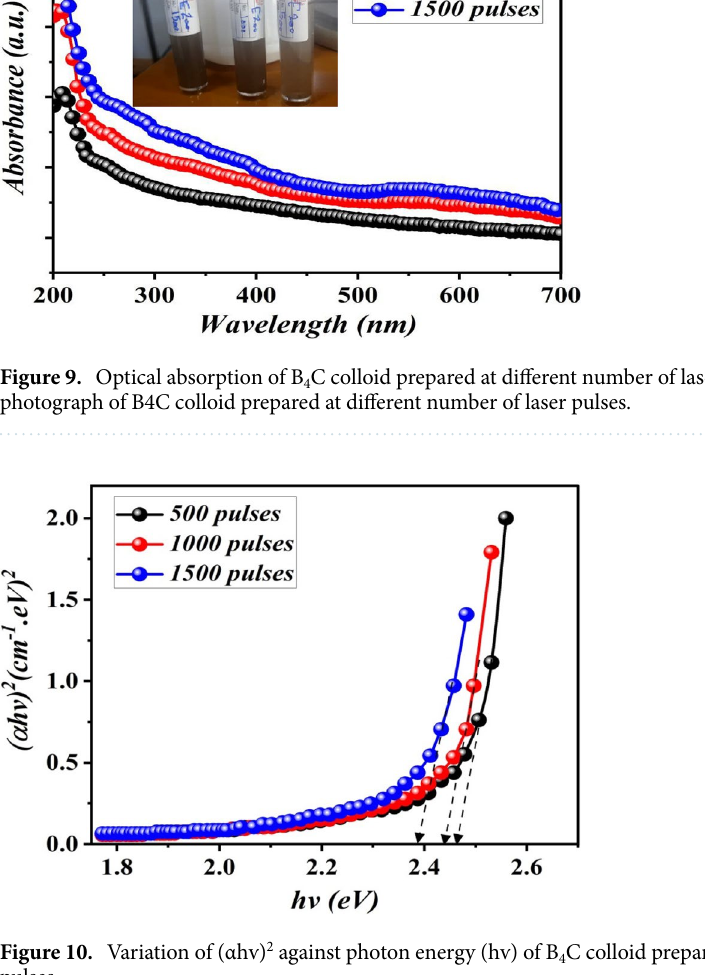
Figure 10. Variation of (αhѵ) 2 against photon energy (hѵ) of B 4 C colloid prepared at different number of laser pulses.